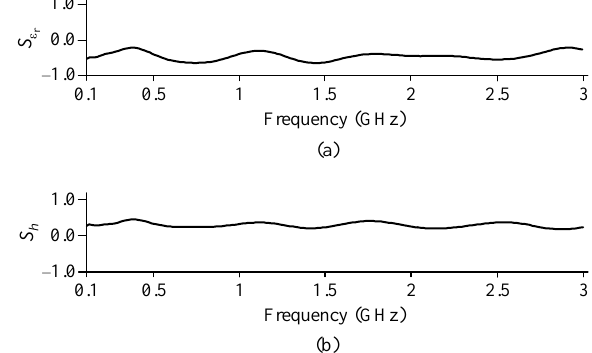
Fig. 10. Impact coefficients on the input impedance of a system when changing: (a) the relative permittivity ɛ r ; (b) the height h of a dielectric substrate